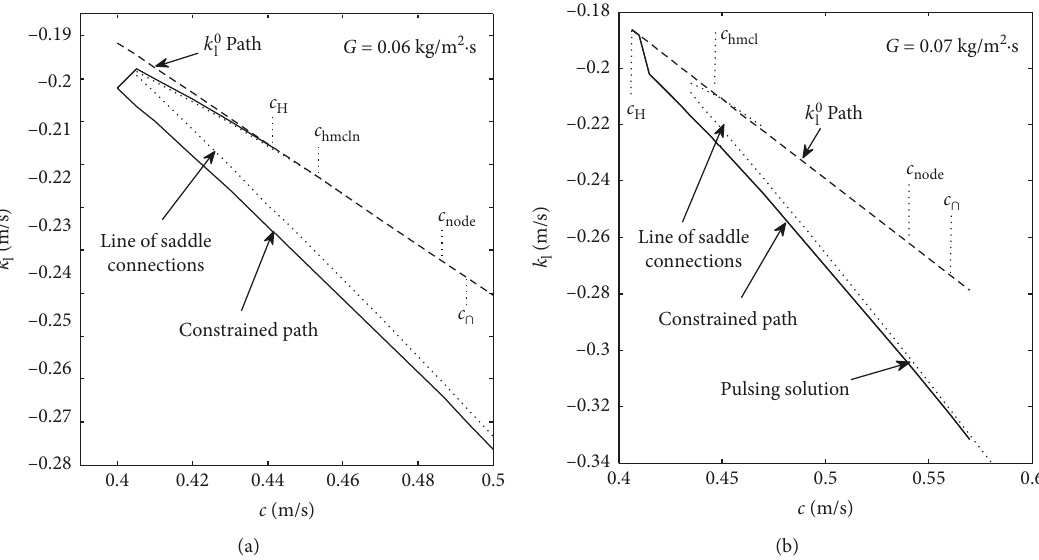
2 s). The air/water trans (cid:31) 0.054kg/m · 2mm and L 15kg/m 2 (cid:31) (cid:31) ·